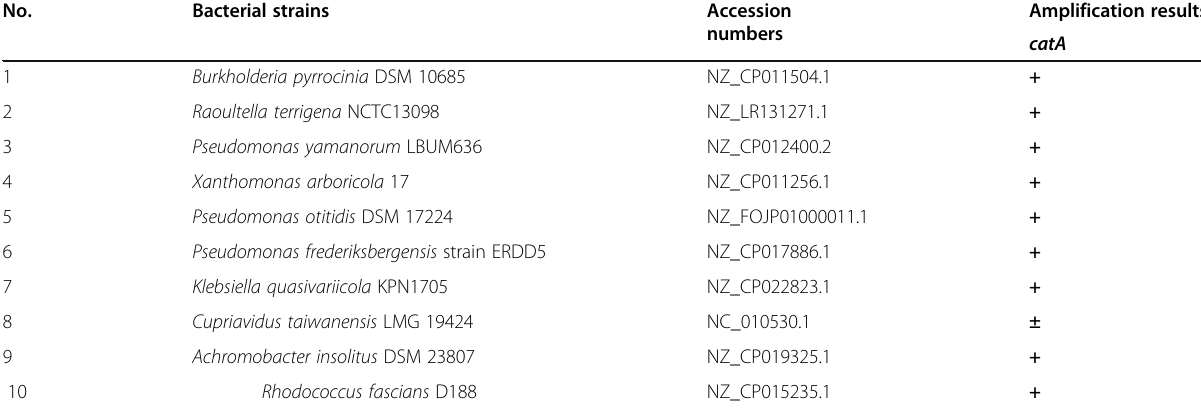
Table 12 In silico PCR result of primer pair catAf/catAr with authentic bacterial strains with (positive control) catechol 1,2- dioxygenase (C12O) gene